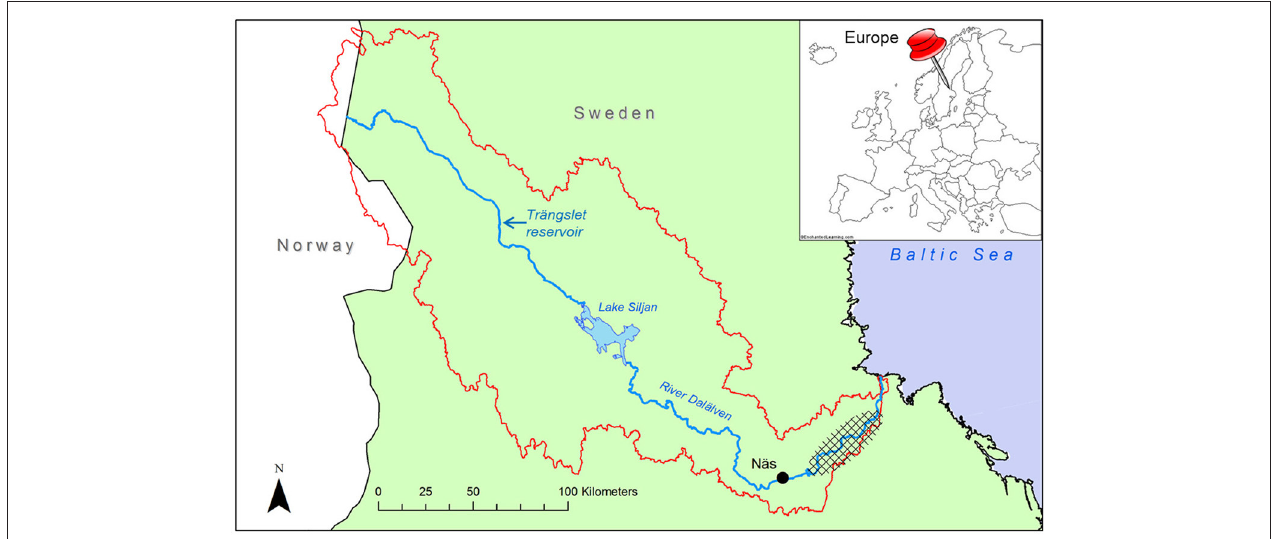
FIGURE 1 | Map showing the catchment borders (red line) of Dalälven River (blue line) in Northern Europe, and the location of the hydropower plant “Näs” (black dot) upstream the regularly flooded residua forest of high biodiversity (checkered).